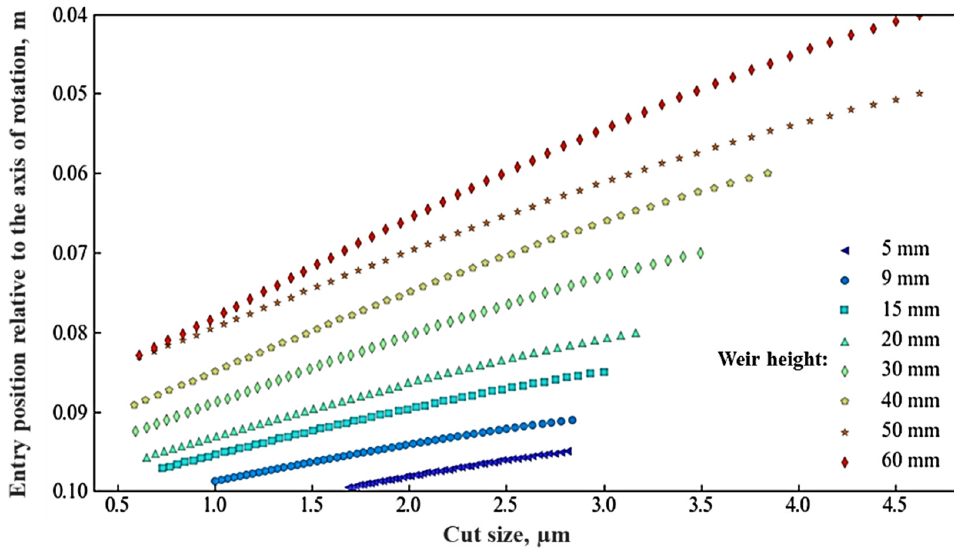
Figure 9. Cut (separation) sizes for particles having entered the sedimentation channel of the SBC from a position ranging from R weir to r rev,in and settled at the last cross-section of the channel, at feed solids concentration 5% and feed flow rate 0.0005 m 3 /s.